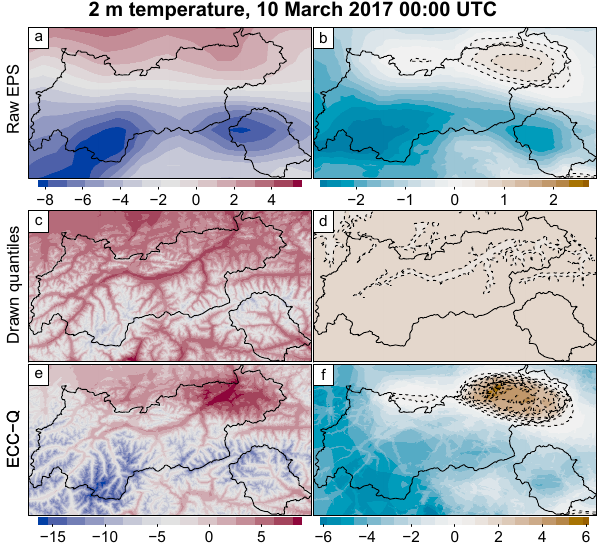
Figure 5. As Fig. 4 but for daily precipitation sums valid 9 March 2017 06:00UTC to 10 March 2017 06:00UTC. Forecasts (a, c, e) and deviations from the ensemble median (b, d, f) are shown in mm24h − 1 . In contrast to Fig. 4 contours are plotted for negative